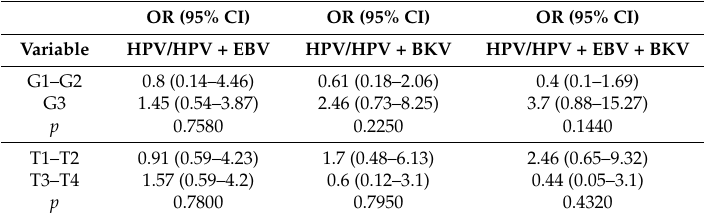
Table 5. Odds ratio of predictive